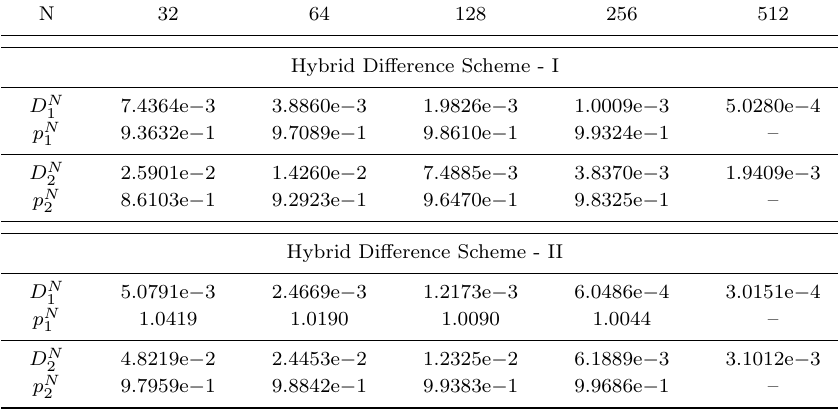
,p N and D N , p N for the Example 2 in the coarse mesh 1 1 2 2